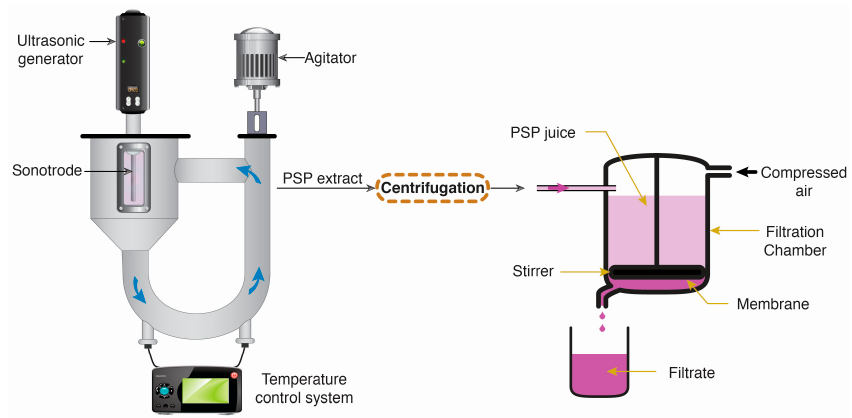
Figure 6. Schematic representation of ultrasonic circulating extraction equipment and ultrafiltration experimental